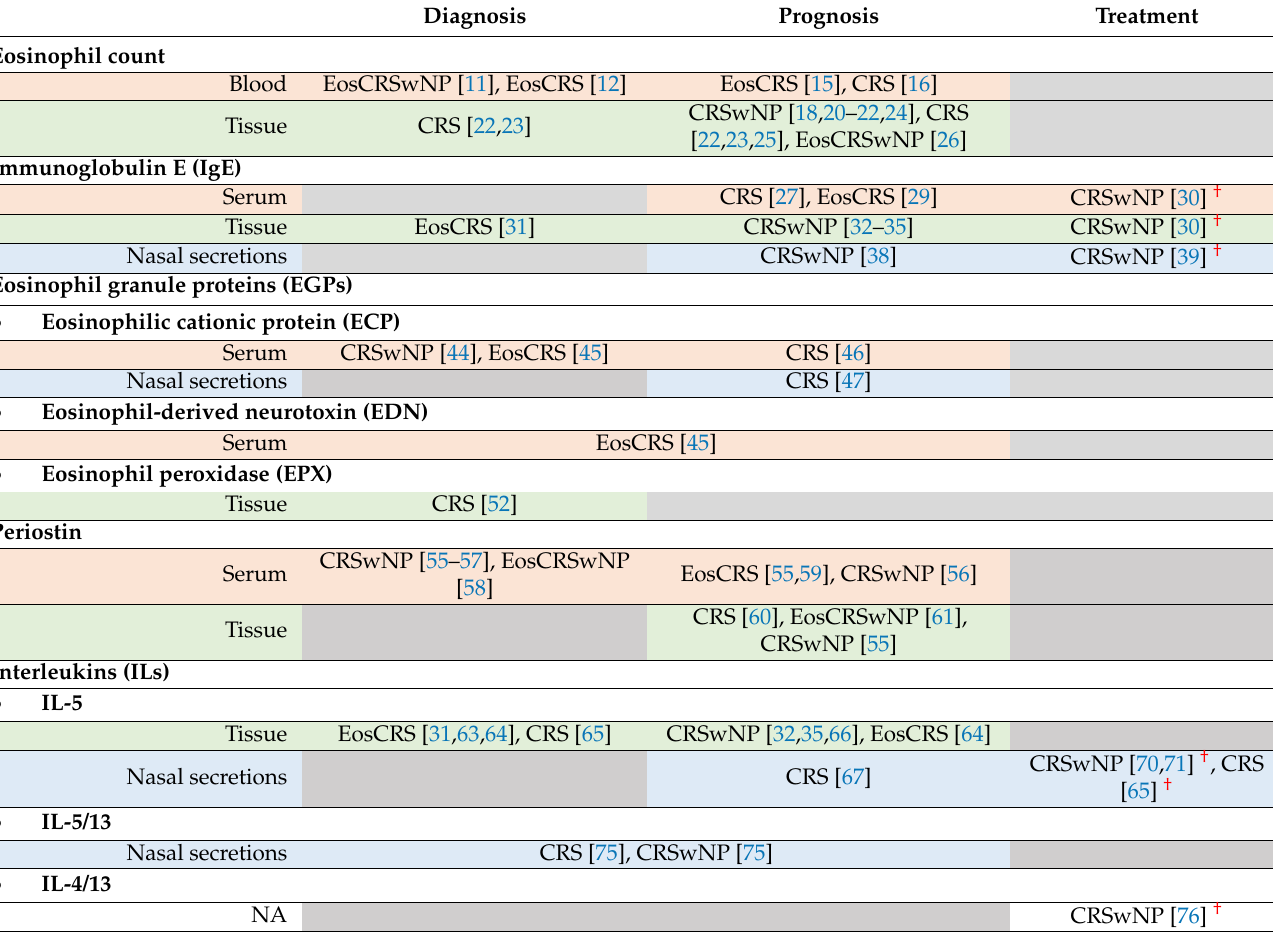
Table 1. Summarized biomarkers characterized by location found, utility, and CRS subtype. *